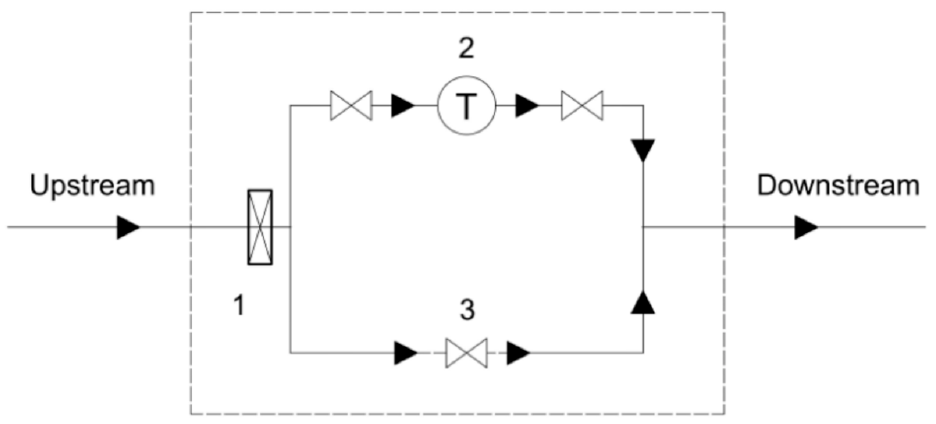
Figure 10. Turbine installation layout of wastewater pipeline (main) upstream of WWTP (simplified bypass scheme): 1—trash rack, 2—turbine, 3—regulating valve. bypass scheme): 1—trash rack, 2—turbine, 3—regulating